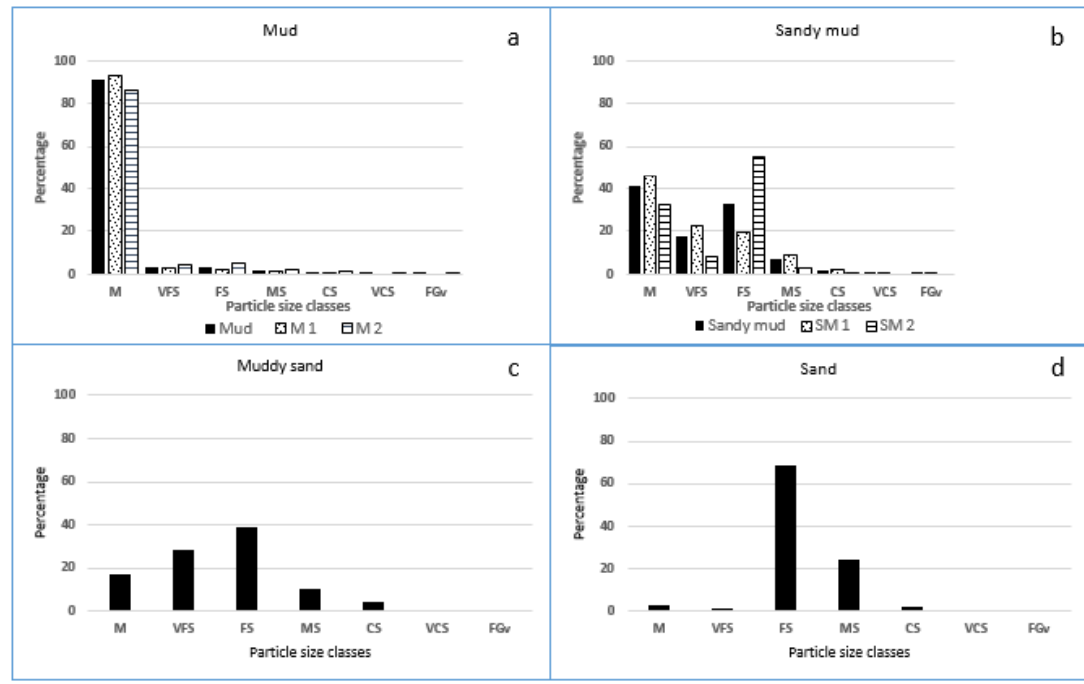
Figure 5. Frequency distribution of grain size classes of Mud ( a ), Sandy mud ( b ), Muddy sand ( c ) and Sand ( d ) in the seabed surface layer. M: Mud, VFS: Very Fine Sand FS: fine sand, MS: Medium Sand, CS: Coarse S, and VCS: Very Coarse Sand, FGv: Fine Gravel.